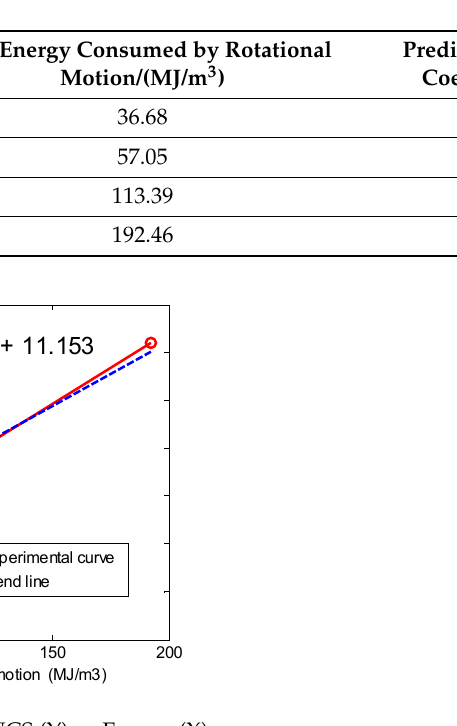
Figure 12. The graph from Table 3 of UCS (Y) vs Energy (X).